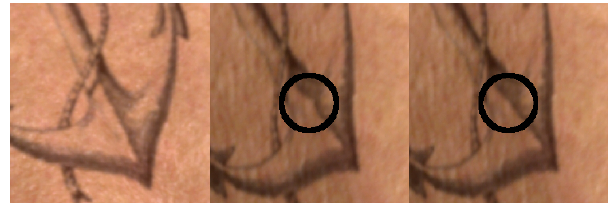
Problematic region in texture space and high contrast closeup for better assessment.